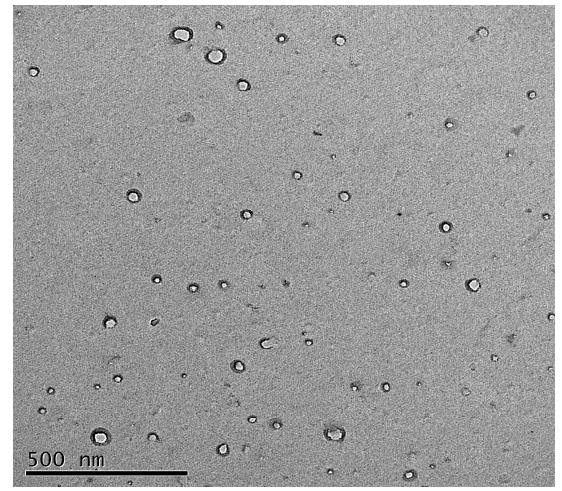
Figure 1. TEM image of CS(DA) NPs.